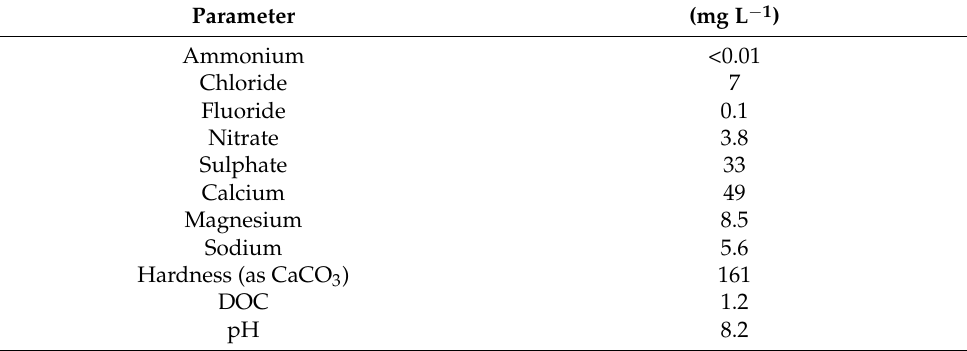
Table 2. Quality characteristics of Lake Constance drinking water.